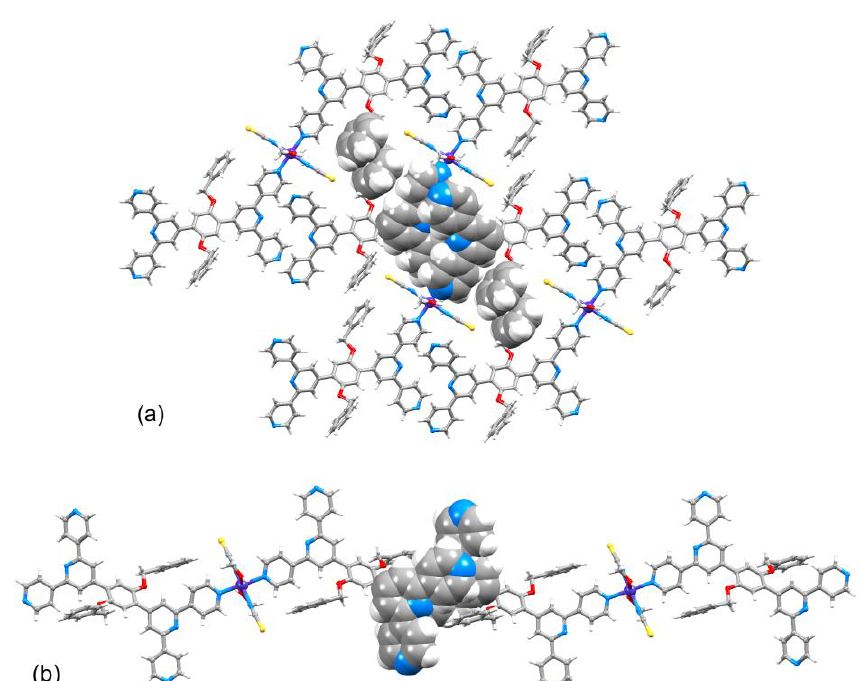
Figure 7. Packing interactions in [Co(NCS) 2 (MeOH) 2 ( 5 ) 2 ]·2CHCl 3 ·2MeOH (solvent molecules omitted) ( a ) between pairs of phenyl rings containing C20 and C20 ii (symmetry code ii = 2 − x , 2 − y , 1 − z ) and pairs of 4,2′:6′,4″-tpy units containing N2/N4 and N2 iii /N4 iii (symmetry code iii = 1 − x , 2 − y , − z ) and ( b ) pairs of 4,2′:6′,4″-tpy units containing N6/N7 and N6 iv /N7 iv (symmetry code iv = 2 − x , − y , 2 − z ).